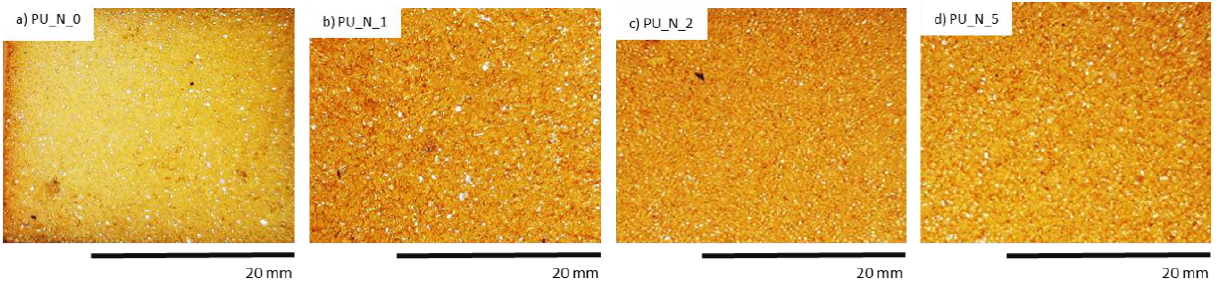
Figure 9. PUR composite foams after the 7 days of UV-aging. Adapted from Ref. [10].